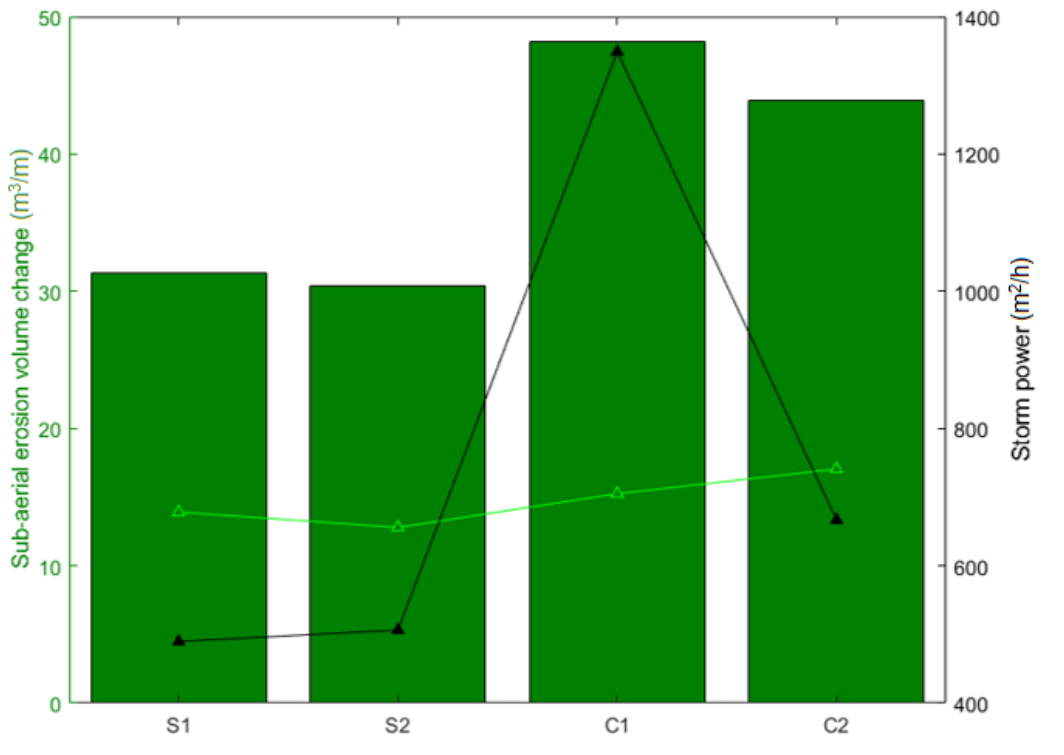
Figure 3. Average subaerial volume changes according to cumulative storm powers (dark triangles). The light green triangles and green bars indicate the average subaerial erosion volume change and that outside of the two standard deviations, respectively. Table 1. Summary of the classified storm events (S1 to C2) and bathymetric surveys available for these